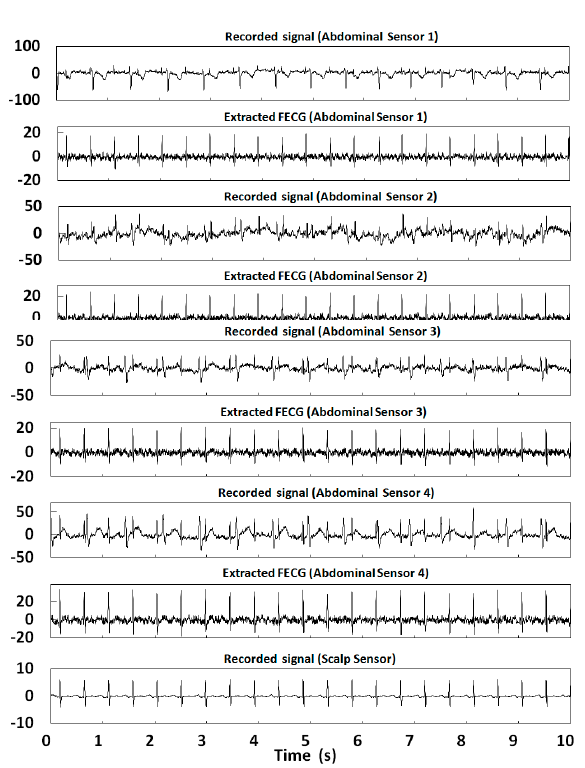
Figure 12. Extraction results for r01 in the ADFECGDB database.